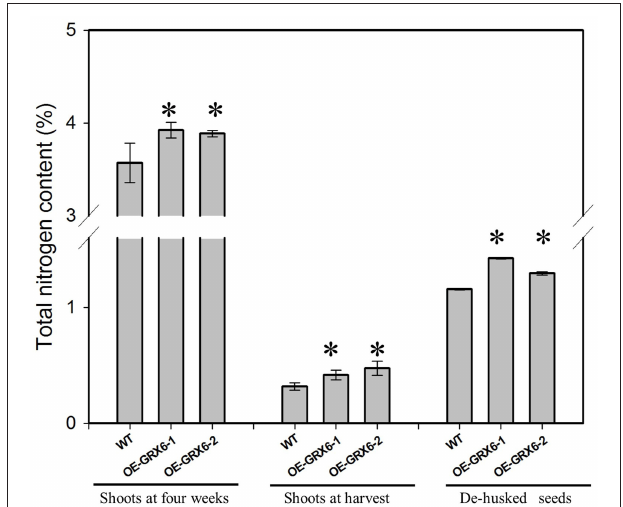
FIGURE 4 | Total nitrogen content in different plant tissues of transgenic and wild type plants. When grown in a full nutrient containing medium, transgenic OsGRX6 plants had significantly higher total nitrogen content in the leaves, shoots, and seeds than that of wild type plants. First two groups represent the total nitrogen in the shoots of wild type and transgenic plants collected either at 4 weeks after planting or at harvest. The last group presents the nitrogen content in de-husked seeds. Data are means ± SD of four replicates. Asterisks indicate significant differences at P ≤ 0.05 level for each group.